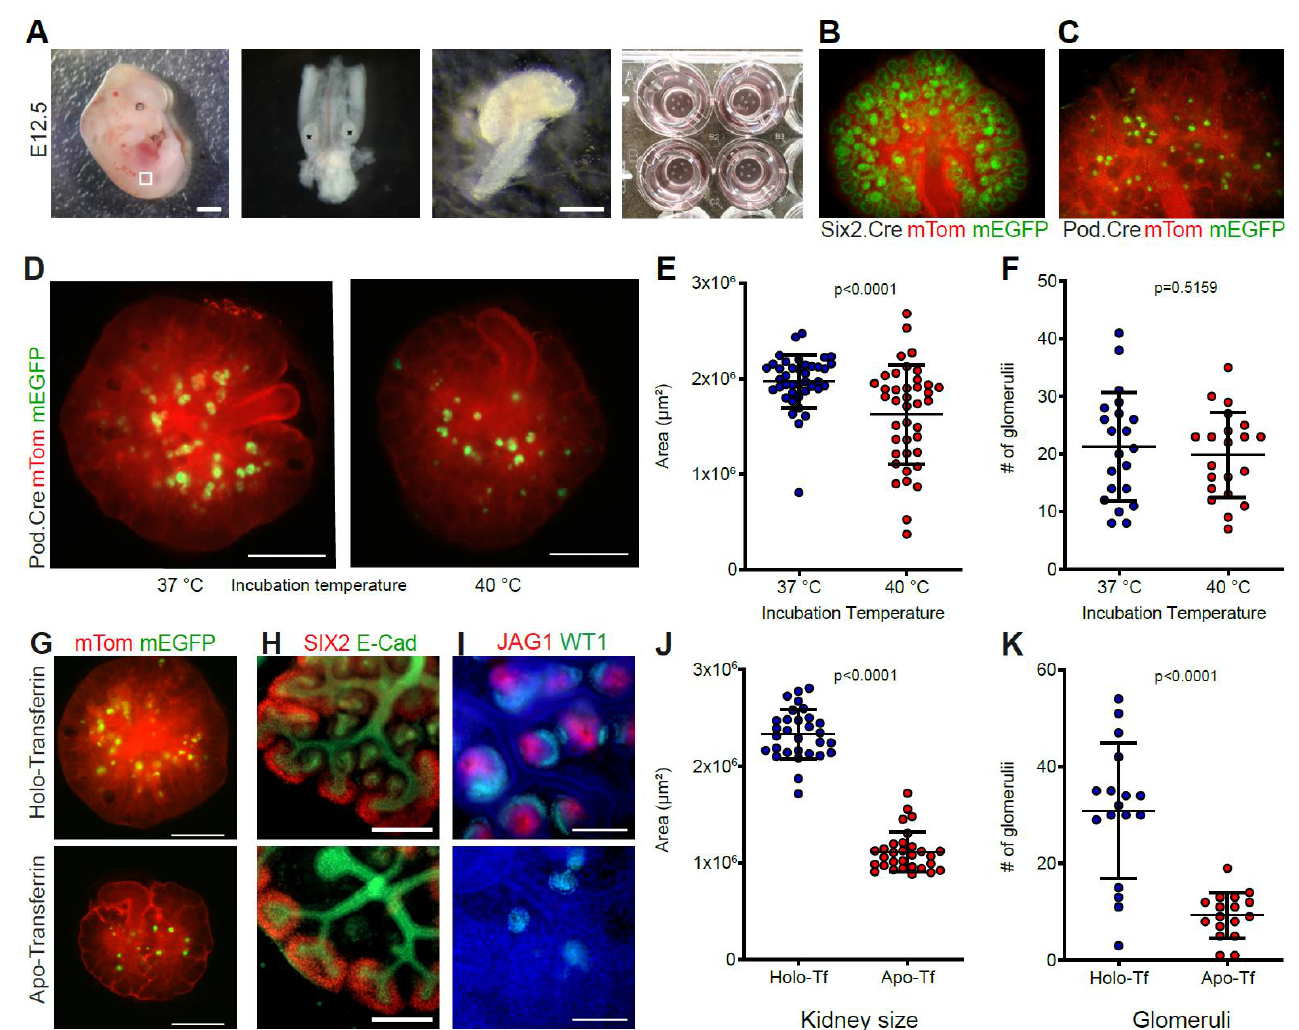
Figure 1. Use of metanephric organ cultures to study the effect of environmental conditions on renal development. ( A ) The urogenital ridge from E12.5 mouse embryos (left panel) was microsurgically extracted (second panel), and the kidneys were isolated (third panel) and placed on Transwell inserts (right panel). Scale bars: 1 mm (left panel), 500 µ m (third panel). ( B ) Transgenic mice with dual Tomato/EGFP expression were used for conditional labeling of Six2-positive cells and their offspring using Six2.Cre or ( C ) podocin-positive cells using Pod.Cre mice. ( D ) Explants from the same embryo cultured for 7 days at 37 or 40 ◦ C. Scale bars: 500 µ m. ( E ) Surface areas of explants grown for 7 days at 37 or 40 ◦ C. n = 40 pairs, paired t -test, mean ± SD. ( F ) Number of glomeruli in the explant groups after 7 days. n = 21 pairs, paired t -test, mean ± SD. ( G ) Explants from the same embryo cultured for 7 days in medium containing holo-Tf or apo-Tf. Scale bars: 500 µ m. ( H ) Widefield images of holo-Tf and apo-Tf cultured explant pair stained against SIX2 and E-cadherin after 48 h of culture show normal progenitor cell pool and defects in early nephron morphology. Scale bar: 100 µ m. ( I ) Widefield images of holo-Tf and apo-Tf cultured explant pair stained against WT1 and JAG1. Scale bars: 100 µ m. ( J ) Surface areas of holo-Tf and apo-Tf cultured explants after 7 days. n = 30 pairs, paired t -test, mean ± SD. ( K ) Number of glomeruli in the explant groups after 7 days. n = 17 pairs, paired t -test, mean ±